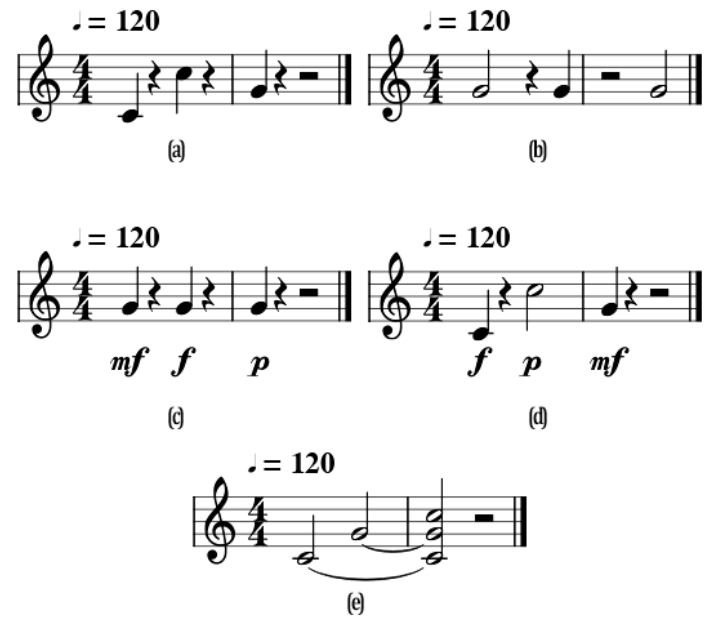
Figure 4. Sound stimuli ( a – e ), represented using musical notation for